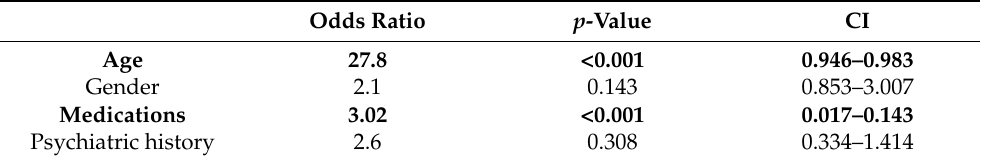
Table 5. Comparison of the co-variates of self-harm by logistic regression, with site as depen- dant variable. Odds Ratio p